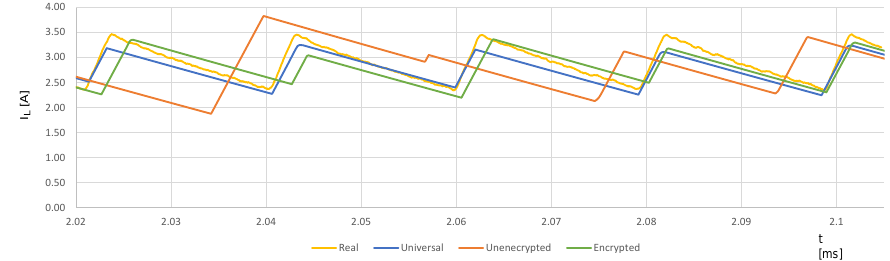
Figure 18. I L models and real measurement time graph curves.